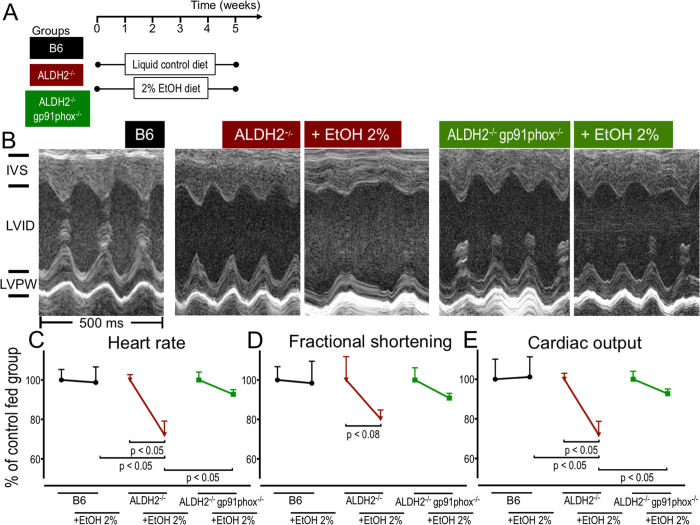
Lack of NOX2/gp91phox protects from alcoholic cardiomyopathy induced by ACA-overload.(A) Scheme depicting the treatment of C57BL/6, ALDH-2−/− and ALDH-2−/−/gp91phox−/− mice with 2% EtOH diet and liquid control diet. (B) Representative M-mode tracings. (C) Heart rate, (D) Fractional shortening and (E) Cardiac output. Data are presented as mean ± SEM from n = 5−12 animals per group and normalized to the respective genotype fed the liquid control diet.